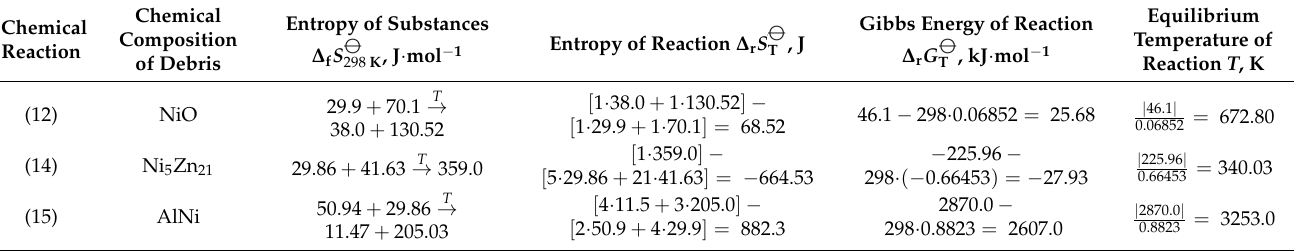
tion with the Ni-coating of the alumina workpiece machined in a water medium. Table 15. Calculated entropy of some Ni-containing substances and equilibrium temperatures. Table 15. Calculated entropy of some Ni-containing substances and equilibrium temperatures. Table 15. Calculated entropy of some Ni-containing substances and equilibrium temperatures. Table 15. Calculated entropy of some Ni-containing substances and equilibrium